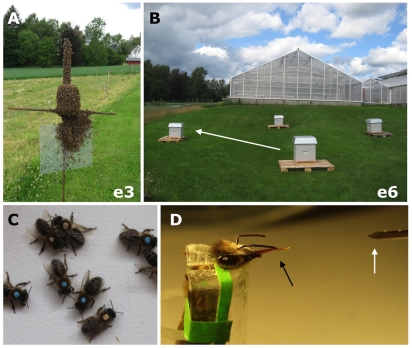
Relating individual performance in unlike memory tasks under free-flight and restrained conditions.(A) Artificial swarm with foragers attracted to a queen. The queen is caged and attached to an iron cross. Swarms, as shown here, were produced prior to moving entire colonies to a new location within an arena of four similar hive boxes (B). Spatial extinction was tested in three separate arenas with four hive boxes. One arena is exemplified here. Colony translocations (white arrow) were used to test the ability of aged bees to extinguish the spatial memory of a previous hive location. (C) Paint marks were applied to track individual foraging age and colony source. (D) In the laboratory, differences in acquisition of olfactory memory were quantified by monitoring the proboscis extension response (PER, black arrow) to the CS (odor, white arrow) during a sequence of 6 CS-US pairings. (e3 and e6 refer to events illustrated in Fig. 3).